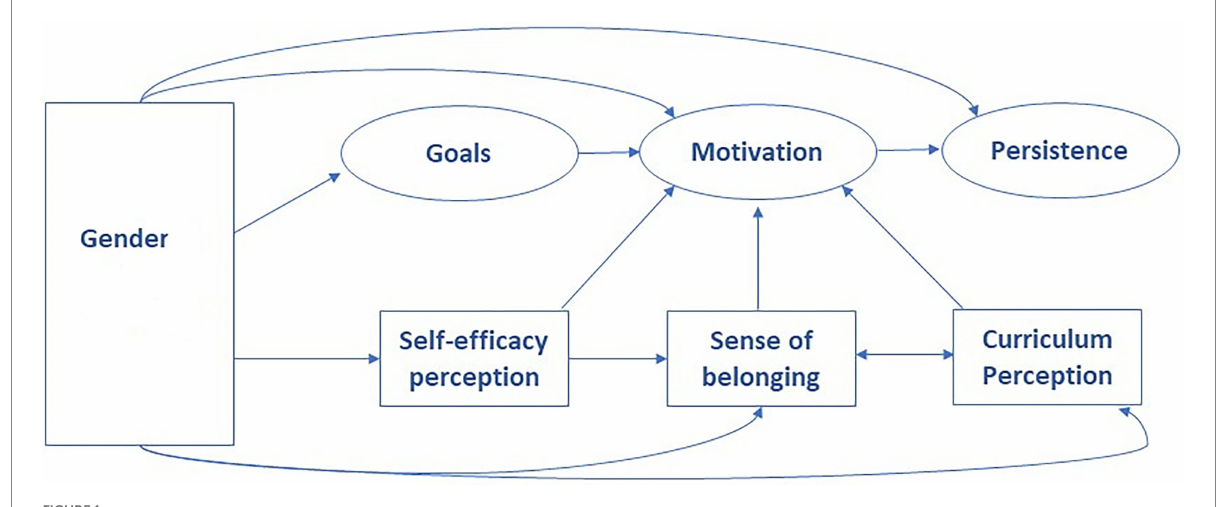
FIGURE 1 The proposed theoretical model of gendered role congruity in students’ motivation and persistence in